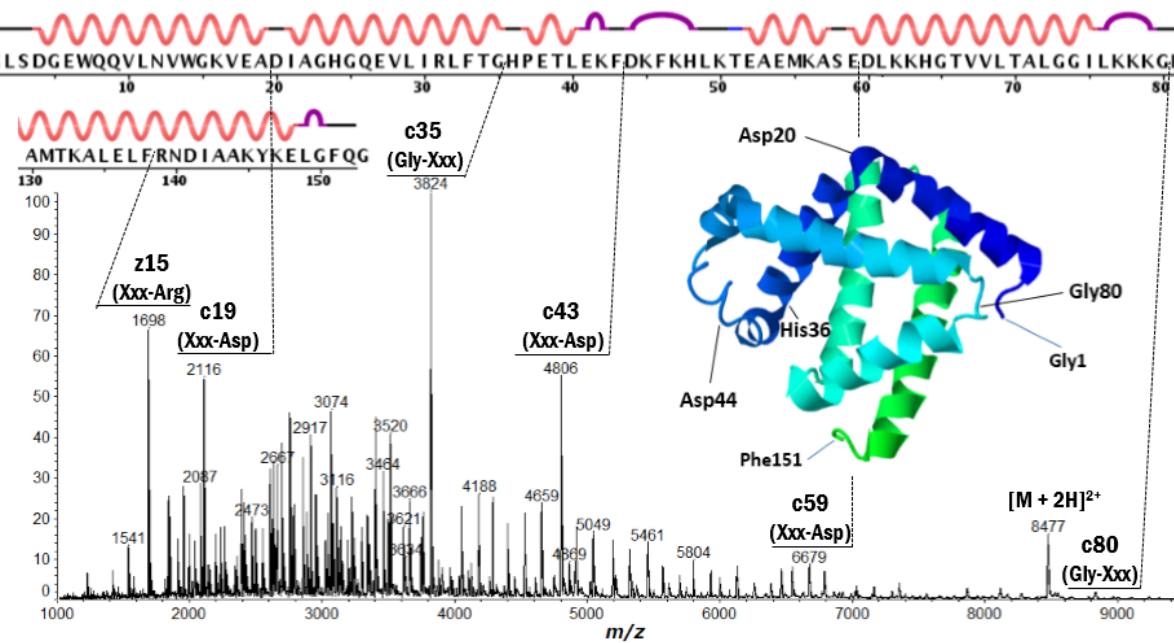
Figure 2. Positive ion MALDI-ISD spectrum of equine apo-myoglobin ( M r 16951.4) obtained with 5-amino-1-naphthol matrix. The inset represents tertiary structure obtained by X-ray crystallography (PDB: 2FRF). The upper line represents primary and secondary structure (wave: α-helix, convex: turn, straight: bend or empty). Adapted from [18] with permissions from Springer, copyright